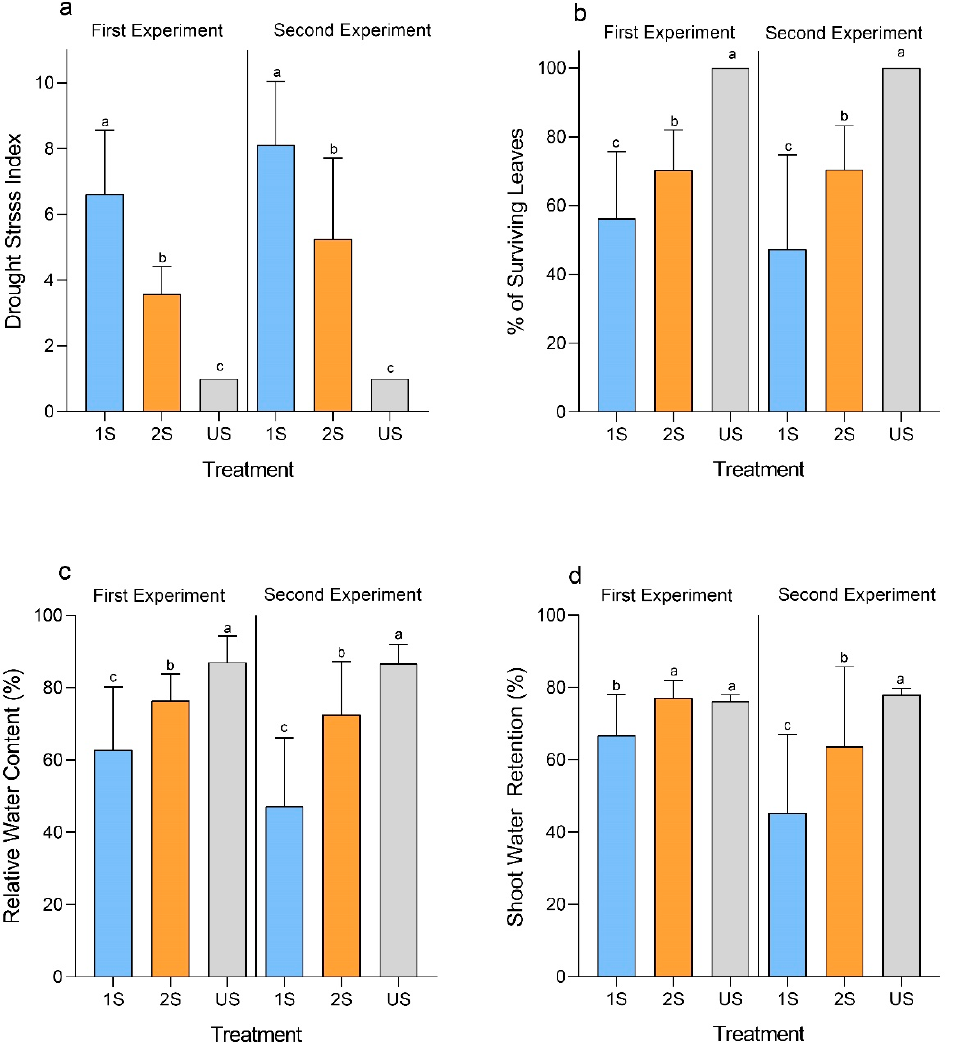
Figure 2. Performance of primed (2S) and unprimed (1S) soybean C08 plants under drought treatment compared to the untreated control (US). ( a ) Drought stress index, n = 28–30 plants. ( b ) Percentage of surviving leaves, n = 20–30 plants. ( c ) Relative water content, n = 19–29 plants. ( d ) Shoot water retention, n = 26–30 plants. Error bars indicate standard deviation. Wilcoxon rank-sum test was used to compare between the mean values of each treatment following one-way ANOVA. Different letters above the bars indicate significant differences between groups at p < 0.05. Each experiment was performed twice (First and Second Experiment), with similar results.